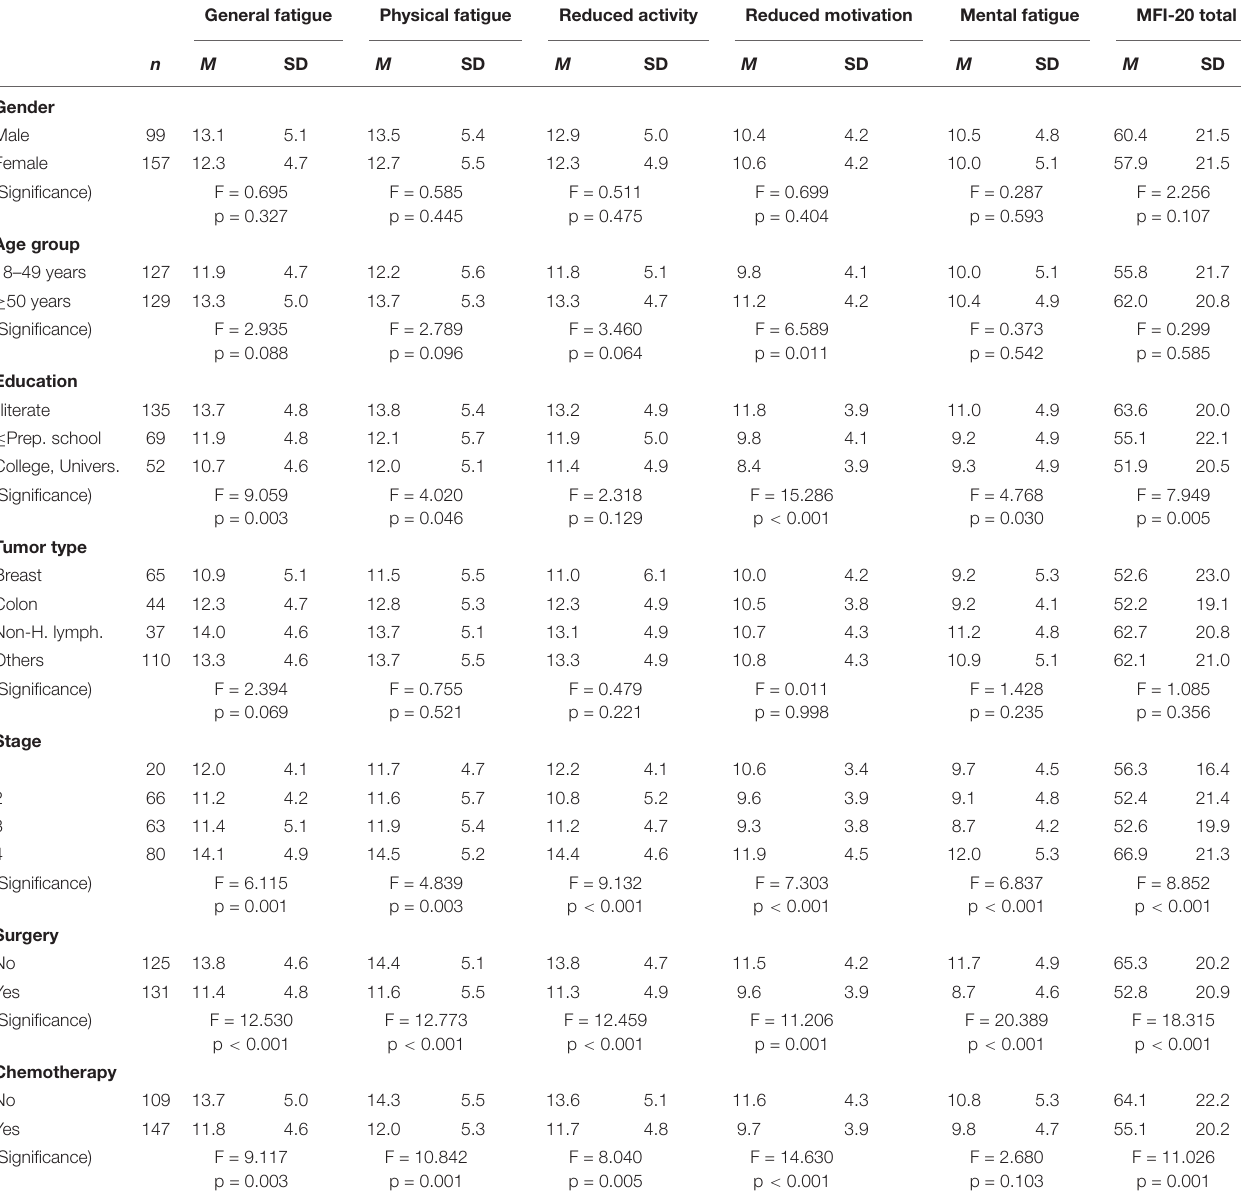
TABLE 3 | MFI mean scores of the Ethiopian sample with socio-demographic and clinical variables. General